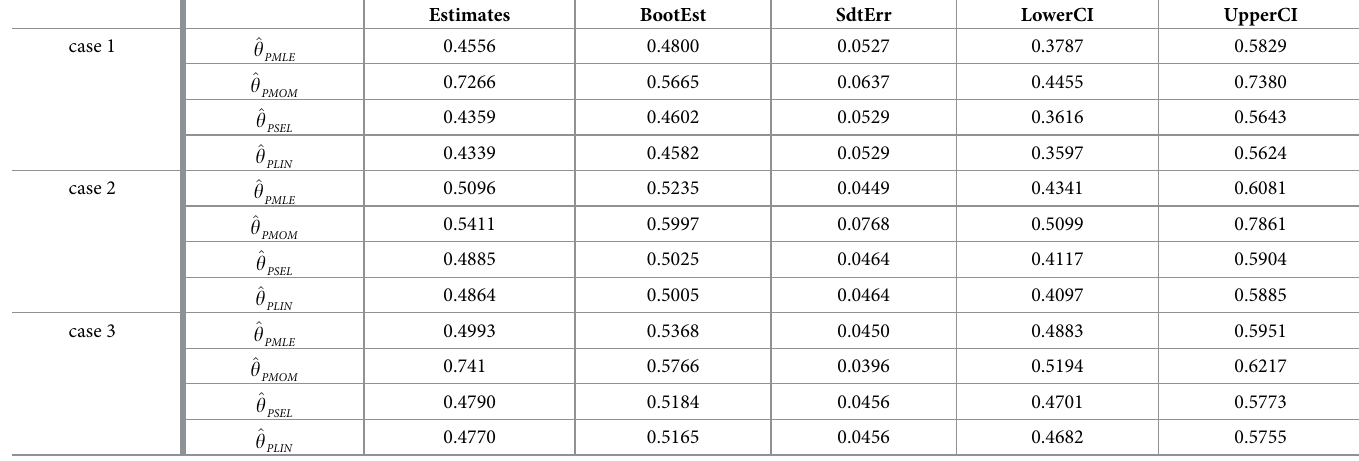
Table 9. Bootstrap results: Bootstrap estimates (BootEst), standard error (StdErr) and 95% confidence interval (LowerCI, UpperCI) for progressively censored data over 1000 resamples.